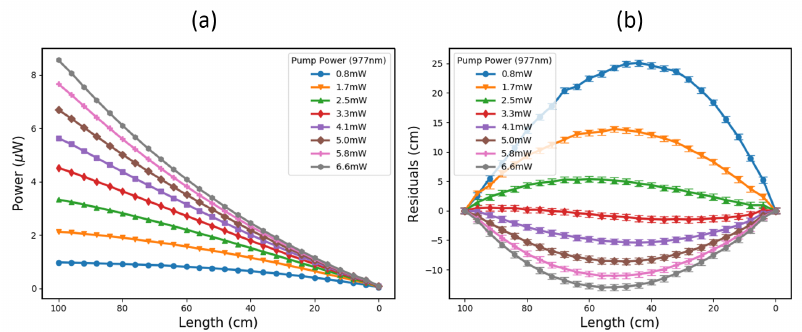
Figure 2. ( a ) Shows the ASE Power vs Length of a 1 m-long Er-doped fibre (Fibrecore I-12) for a range of pump powers. ( b ) Shows the residuals compared to an ideal, linear Power vs Length relationship. The uncertainty bars correspond to the ± 0.5 cm cutback